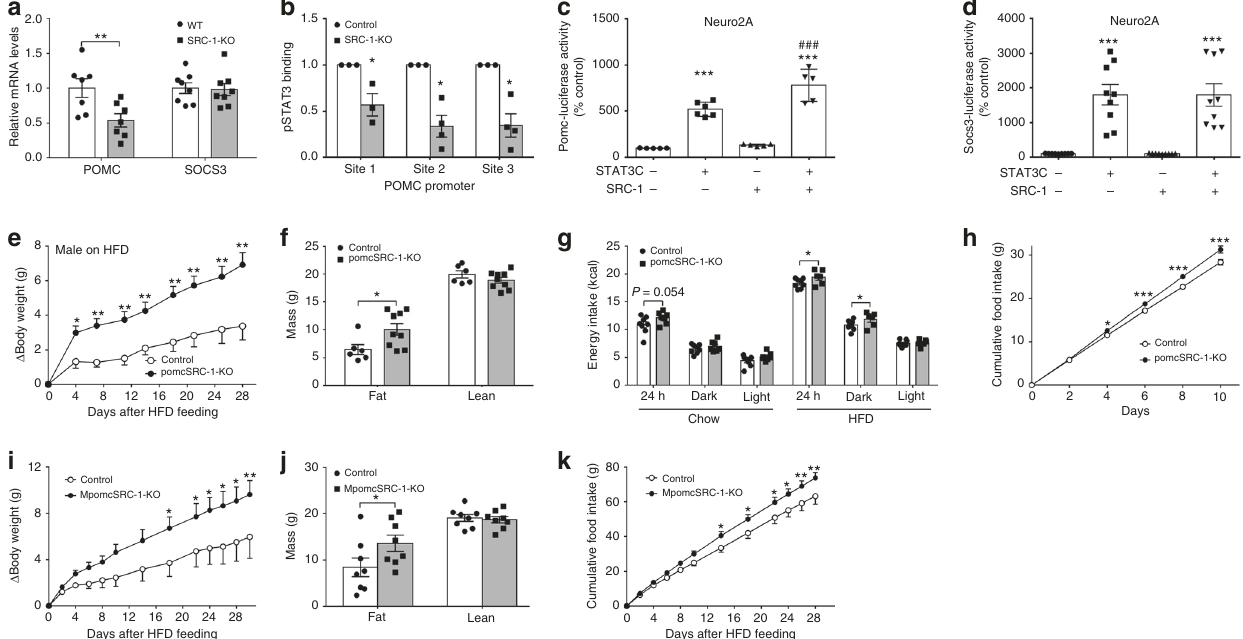
Fig. 1 SRC-1 potentiates STAT3-induced Pomc expression. Numbers of mice/repeats in each group are indicated; data are presented as mean ± SEM and compared using T -tests or two-way ANOVA followed by post hoc Sidak tests (#). a Pomc and Socs3 mRNA levels in hypothalami from 16-week old SRC-1- KO and WT control littermates ( n = 7/8); ** P < 0.01. b ChIP assays detecting pSTAT3 binding on Pomc promoters in hypothalami from male SRC-1-KO and control littermates 30 min after leptin injections (5 mg/kg, i.p.): site 1, − 998 to − 989; site 2, − 361 to − 353; site 3, − 76 to − 68 upstream of Pomc ( n = 3/ 4); * P < 0.05. c , d Effects of overexpressed constitutively active STAT3 and SRC-1 on Pomc- ( c ) or Socs3-luciferase activity ( d ) in Neuro2A cells ( n = 5 – 9 independent experiments). *** P < 0.001 vs. empty vectors; ### P < 0.001 vs. STAT3 alone (#). e Change ( Δ ) in body weight after male control and feeding ( n = 6/9); * P < 0.05. g Energy intake measured by CLAMS chambers in 12-week old male mice matched for body weight, lean mass, and fat mass. Mice were subjected to a 2-day-chow – 2-day-HFD protocol, and chow was replaced by HFD before the onset of dark cycle on day 3. Energy intake was averaged for 2-day chow feeding period and for 2-day HFD feeding period ( n = 7/8); * P < 0.05. h Cumulative HFD intake measured in 12-week old male mice singly housed in home cages ( n = 10/14); * P < 0.05 (#). i Change in body weight after control and MpomcSRC-1-KO mice were switched on a HFD at the age of day 84 ( n = 8); * P < 0.05 (#). j Fat mass and lean mass measured 30 days after HFD feeding ( n = 8); * P < 0.05. k Cumulative HFD intake measured in 12-week old male mice ( n = 6/7); * P < 0.05 (#), ** P < 0.01. Source data are provided as Source Data Fig.